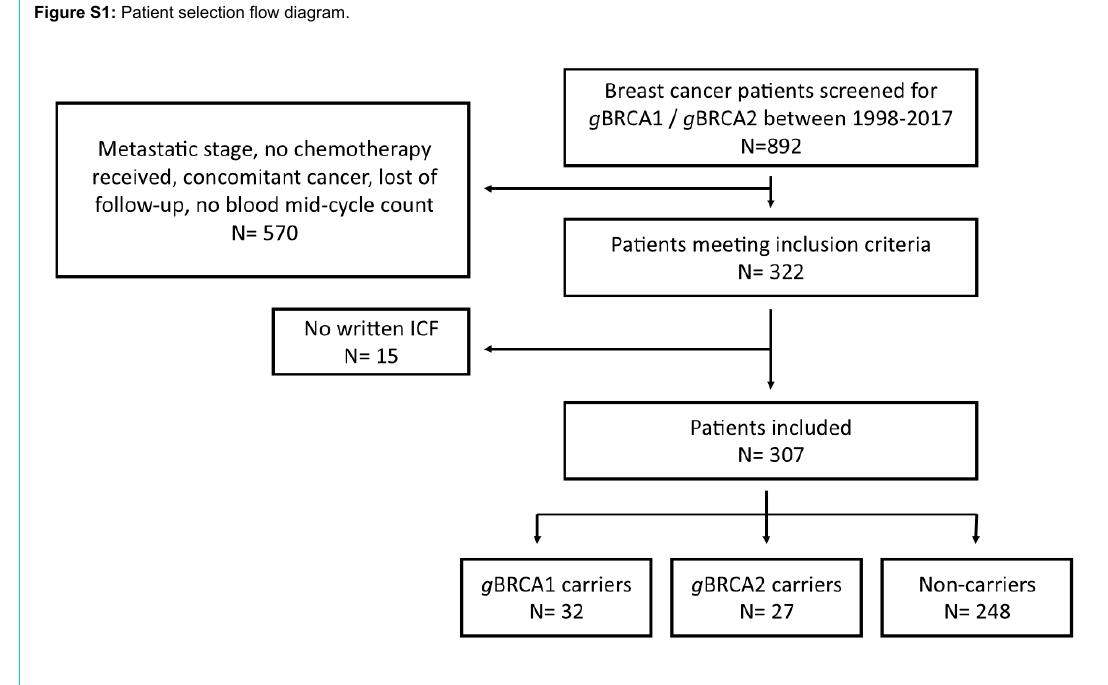
Figure S1: Patient selection flow diagram.